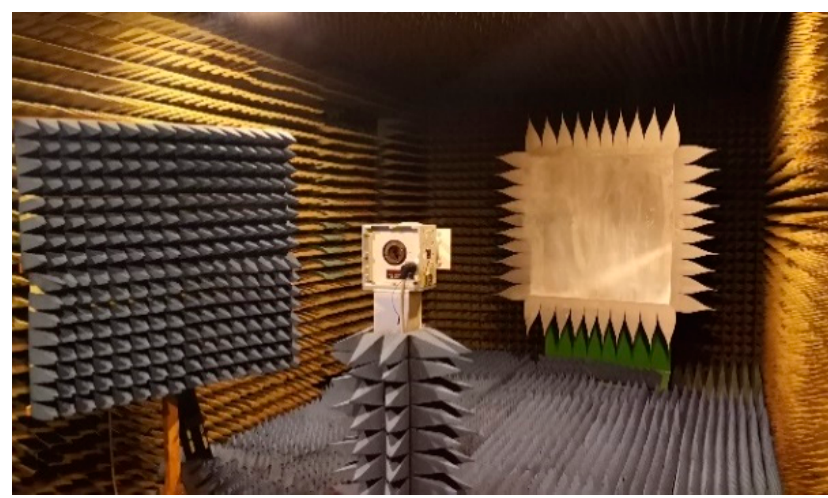
Figure 15. CATR anechoic chamber with reflector and serrations, Rx antenna on rotating mast and Tx antenna (behind absorbing wall cones).